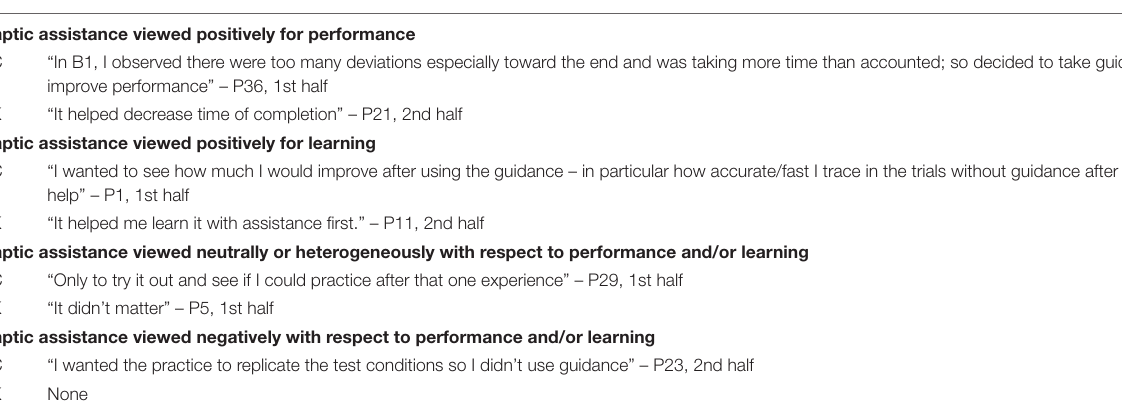
TABLE 2 | Selected quotes from Self-controlled (SC) and Yoked (YK) participants which support each of the four emergent themes. Haptic assistance viewed positively for